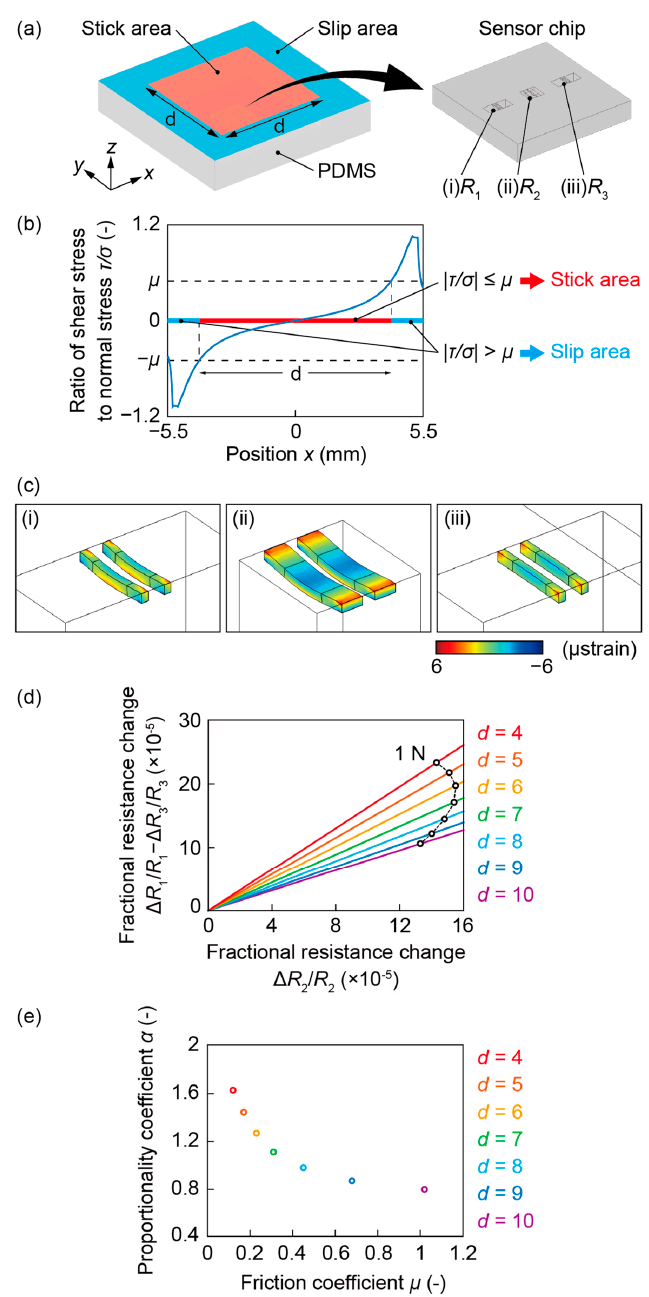
Figure 4. Simulation results. ( a ) The developed model; ( b ) Stress distribution on the contact area; ( c ) Deformation of the beams; ( d ) Relationship between two fractional resistance changes, Δ R 2 / R 2 and Δ R 1 / R 1 — Δ R 3 / R 3 ; ( e ) Relationship between the proportional coefficient α and the friction coefficient μ .